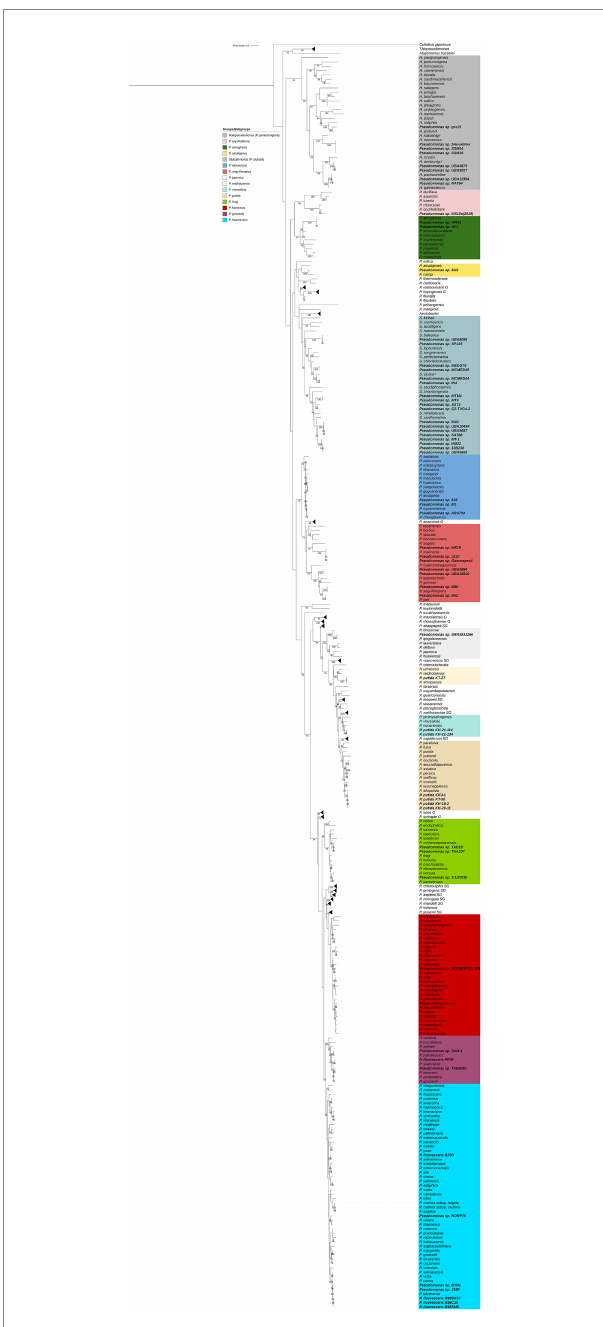
FIGURE 1 Phylogenetic tree of the Pseudomonadaceae based on the rpoD gene of type strains (Supplementary Table S2) and environment strains (Supplementary Table S3). The maximum likelihood phylogenetic tree was constructed using the GTR + G + I model (MEGA-X). Bootstrap values were calculated based on 1,000 replications and only bootstrap values higher than 50% are shown. Environmental strains are highlighted in bold. C. japonicus is used as the